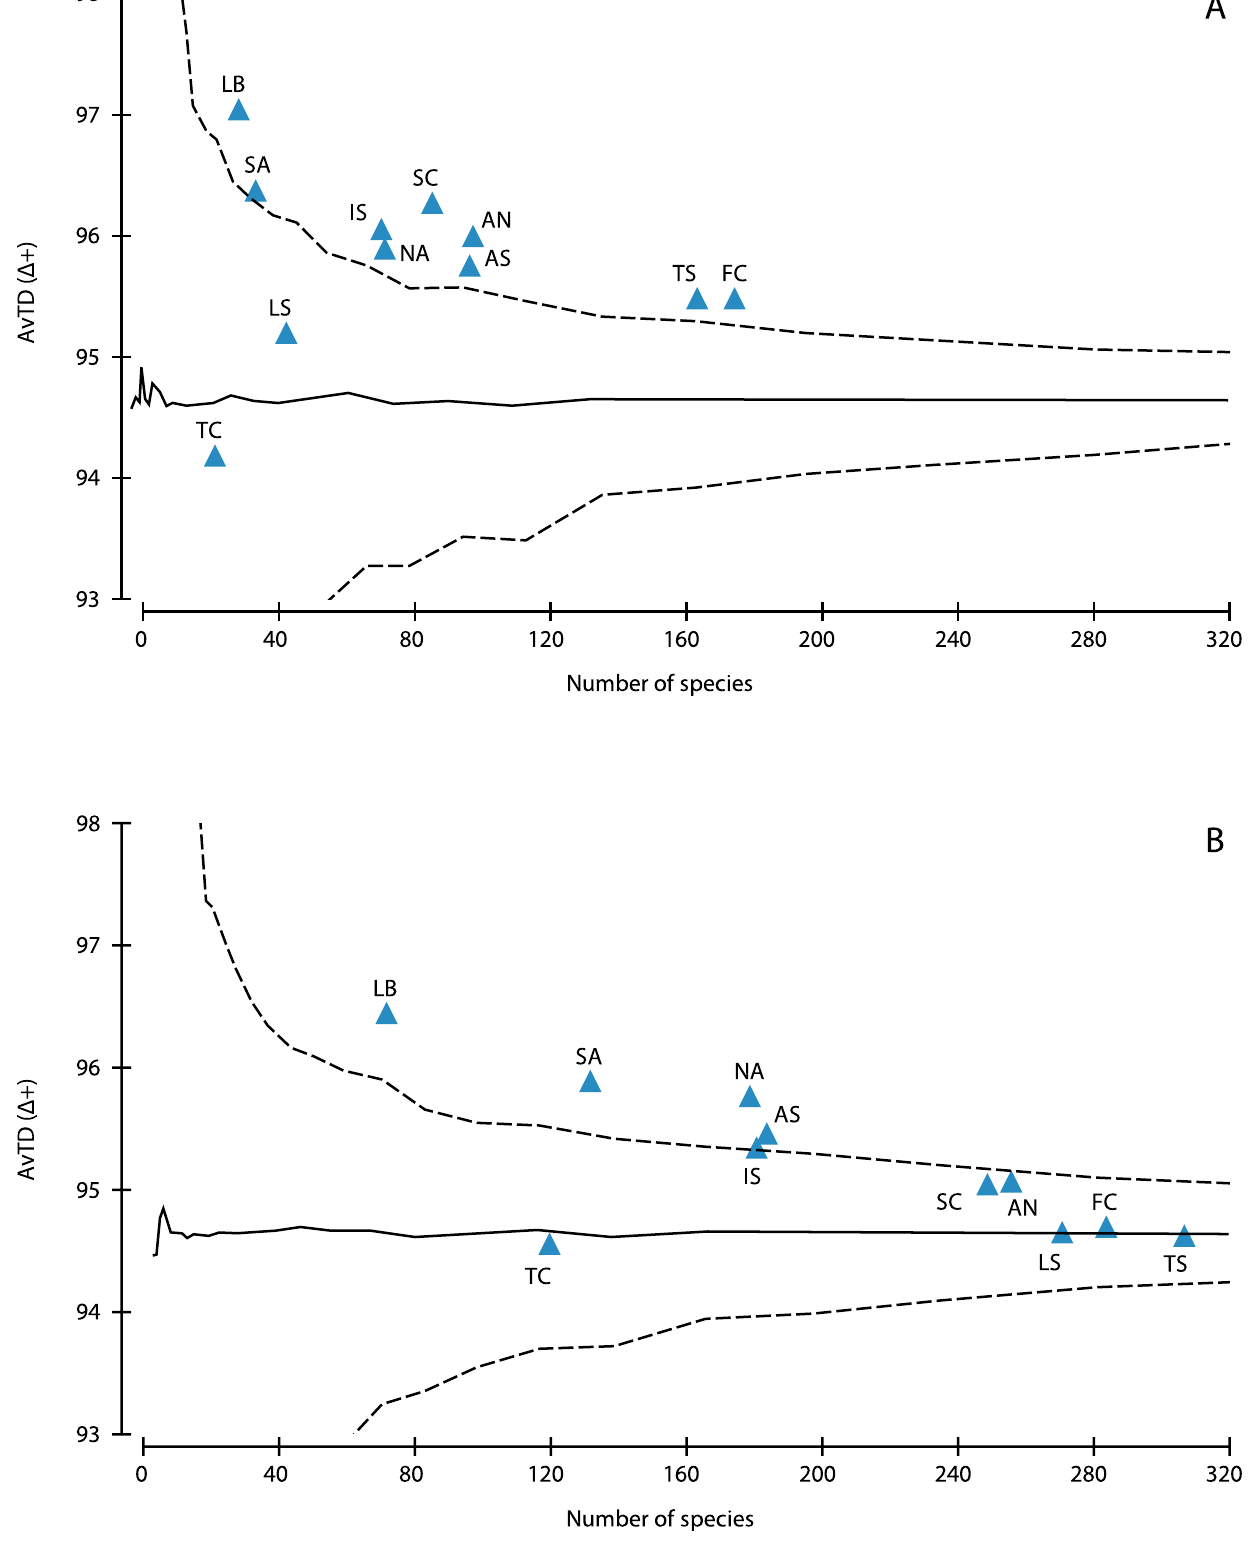
Figure 5. Average taxonomic distinctness (AvTD) for the Mediterranean subareas. (A) cave sponge fauna, (B) overall Mediterranean sponge fauna. The central line represents the mean value and the funnel curve shows the limits for its expected values. For abbreviations of Mediterranean areas see Methods.